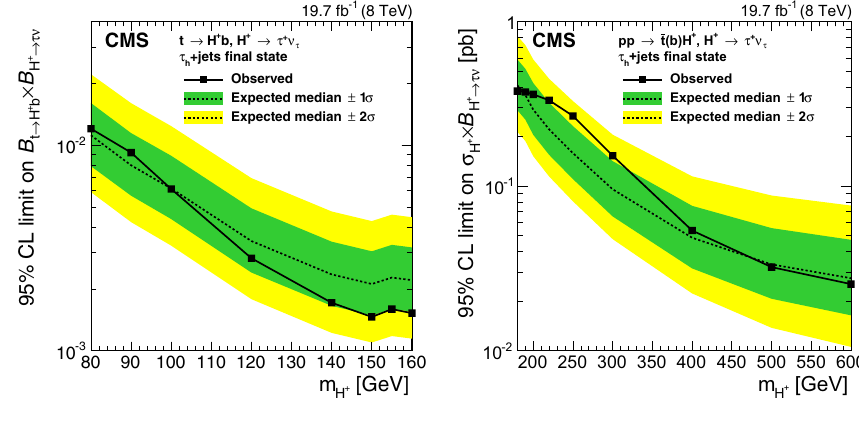
Fig. 21 CMS model-independent upper limits on BR ( t → H + b ) × BR ( H + → τ + ν τ ) ( left ) and on σ( pp → t ( b ) H + ) × BR ( H + → τ + ν τ ) ( right ). (Reprinted with kind permission from JHEP and the authors, Fig. 8 of